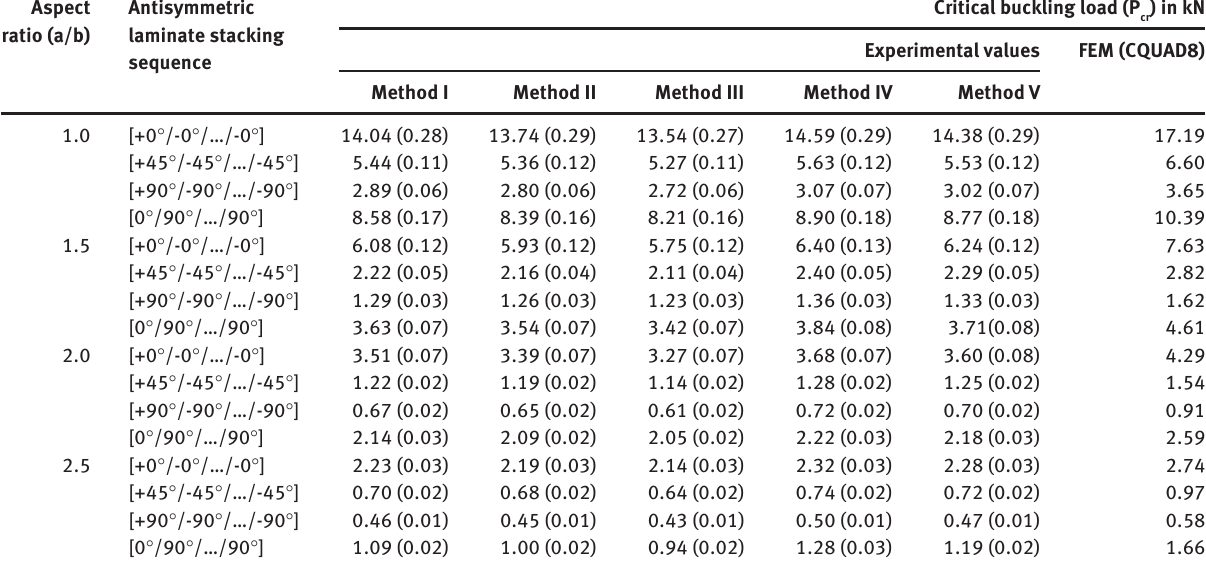
The numbers in parentheses represent the standard